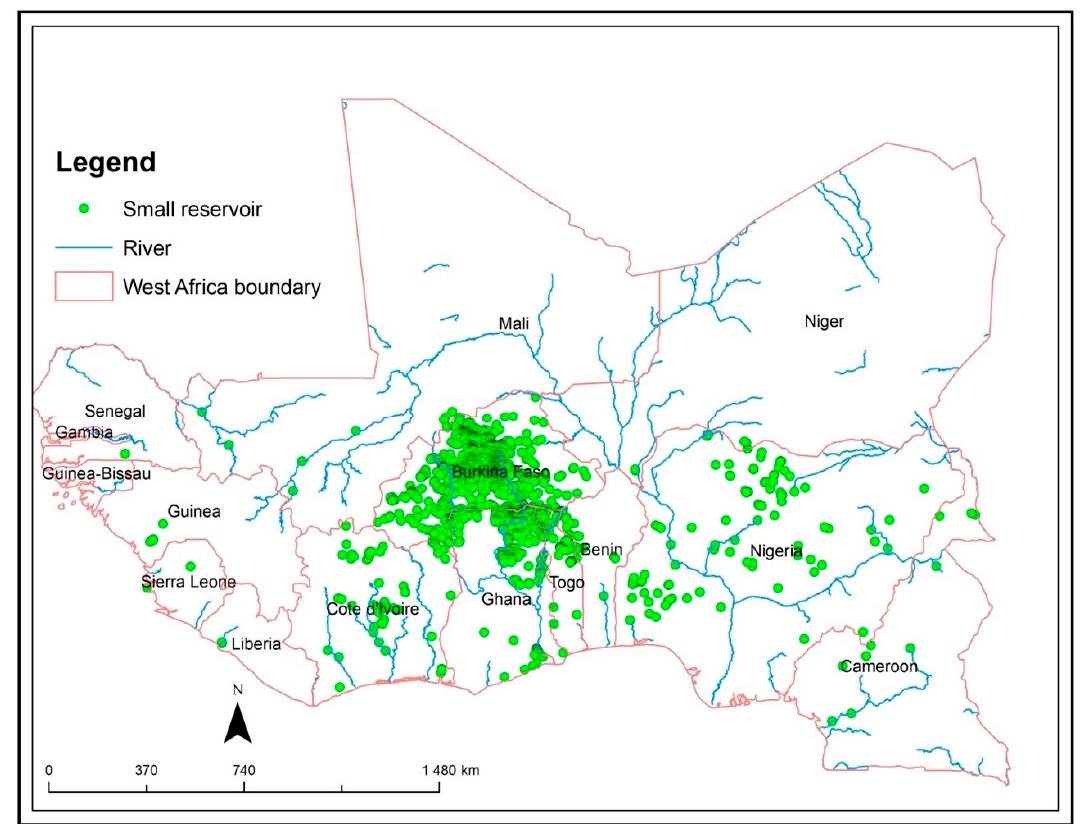
Figure 2. Small reservoir distribution across West Africa (source: prepared for this study).